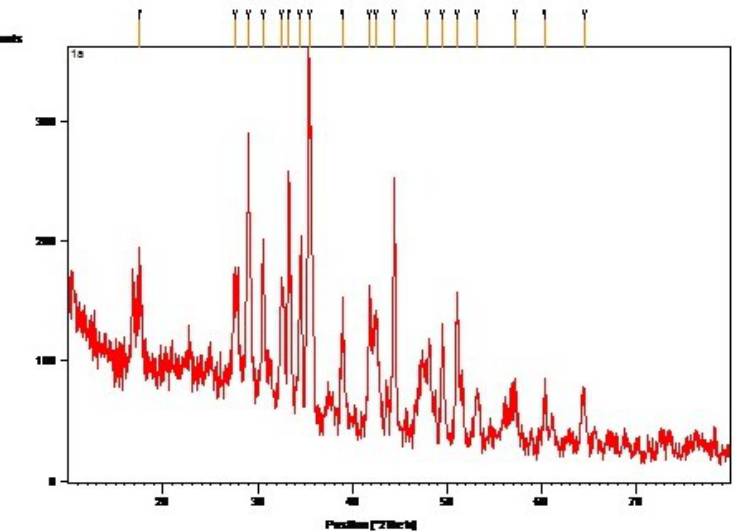
Figure 2 . XRD spectrum of polyreactive blue MXR dye.